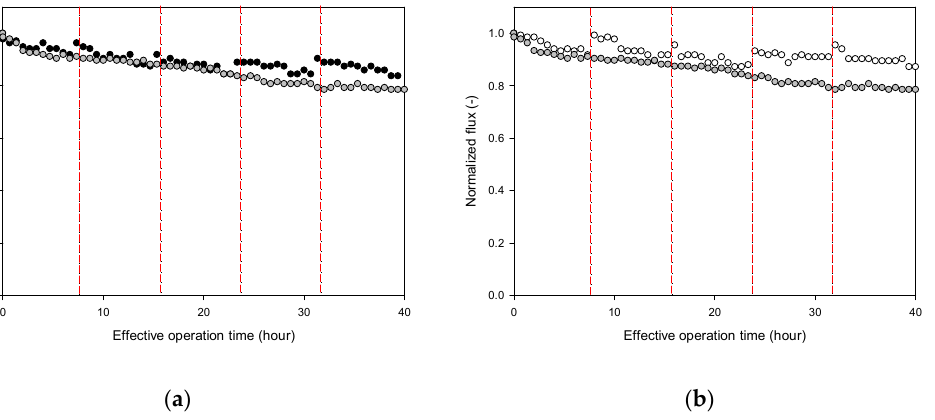
Figure 7. Time-dependent profiles for flux and foulant layer thickness for 40 h of intermittent operation. The red dashed line represents the time for stopping and restarting. black color is Case 2 operation, gray color is continuous operation, and white color is Case 3 operation. ( a ) RO operation with membrane storage in the feed water (Case 2). ( b ) RO operation with the membrane storage in DI water (Case 3).